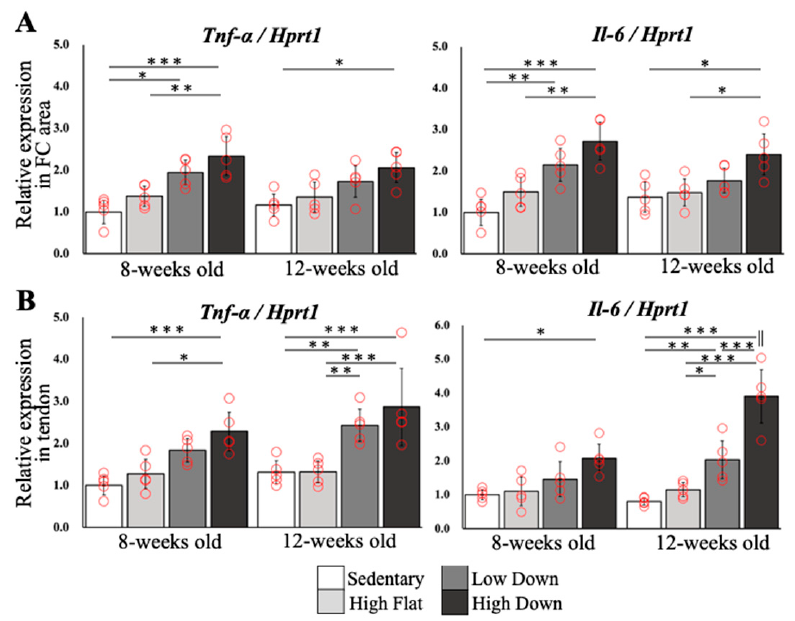
Figure 7. Comparison results of relative gene expression levels. ( A ) Results of comparison of relative gene expression levels of Tnf- α and Il-6 in the enthesis FC area. ( B ) Results of comparison of relative gene expression levels of Tnf- α and Il-6 in tendons. Statistical significance: * p < 0.05, ** p < 0.01, *** p < 0.001. || p < 0.05 (8-week-old mice in the High Down group vs. 12-week-old mice in the High Down group).